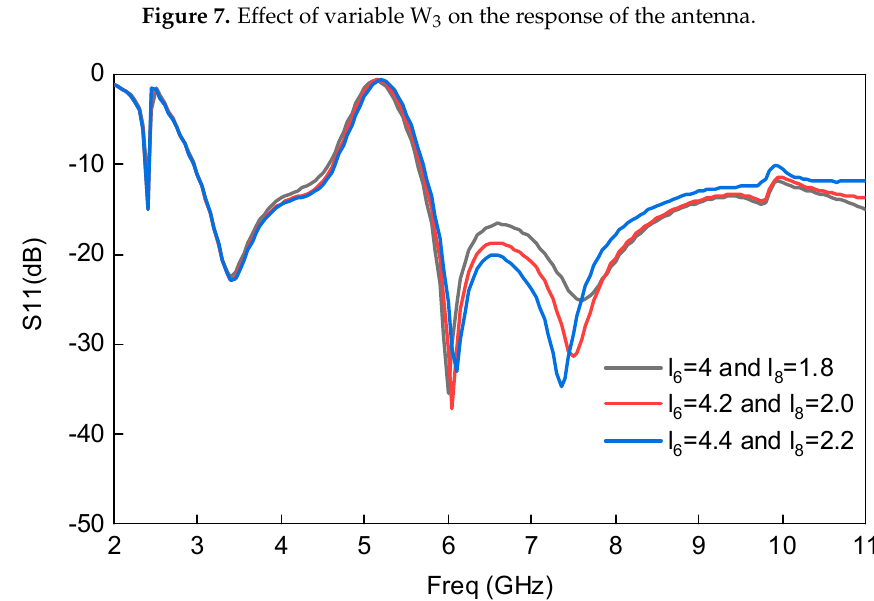
Figure 8. Effect of variable l 6 and l 8 on the response of the antenna.